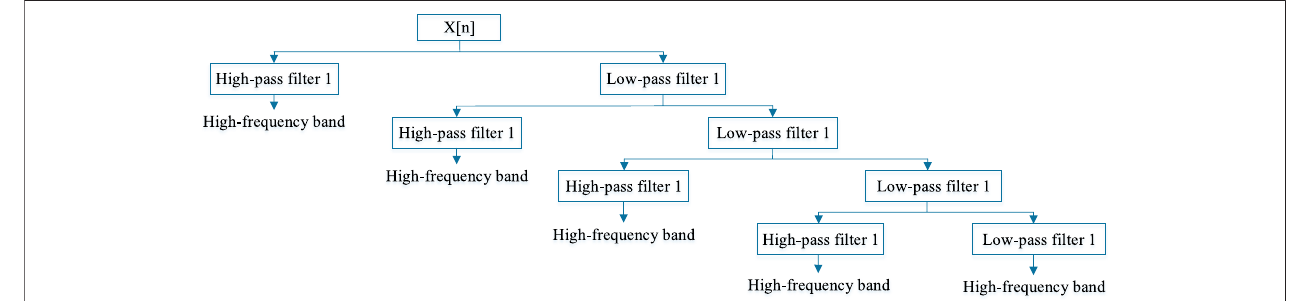
FIGURE 3 | The 4-stage DWT